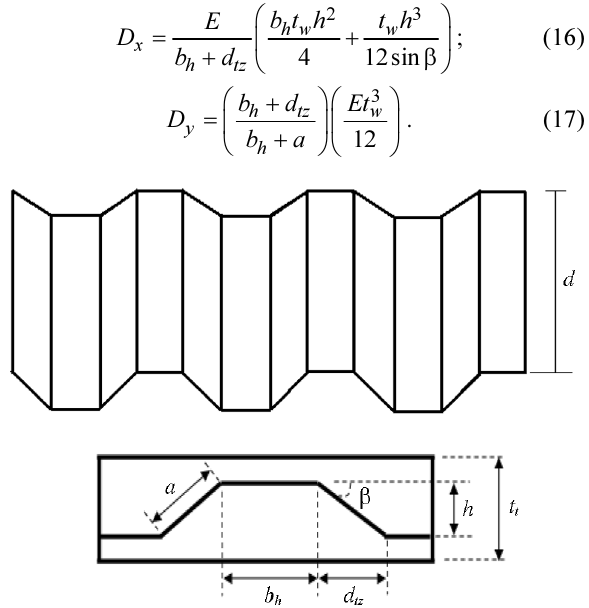
Fig. 7. Trapezoidal profile of the corrugated web plates